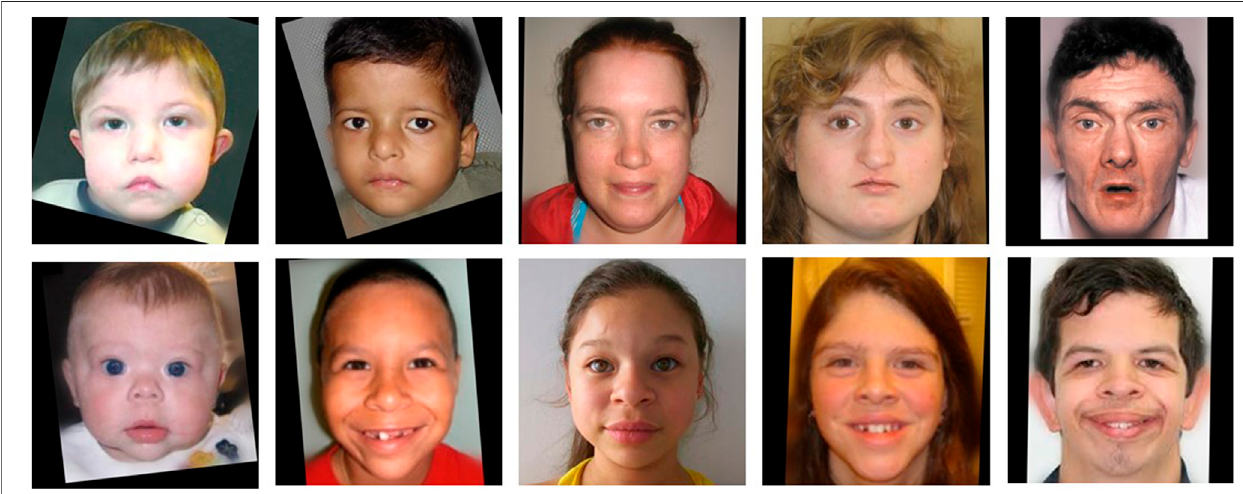
FIGURE 1 | Centered and aligned images of real individuals (different individuals are shown at different ages) affected with 22q (top row) and WS (bottom row). These images have been previously published and are granted to be freely distributed for noncommercial research purposes.